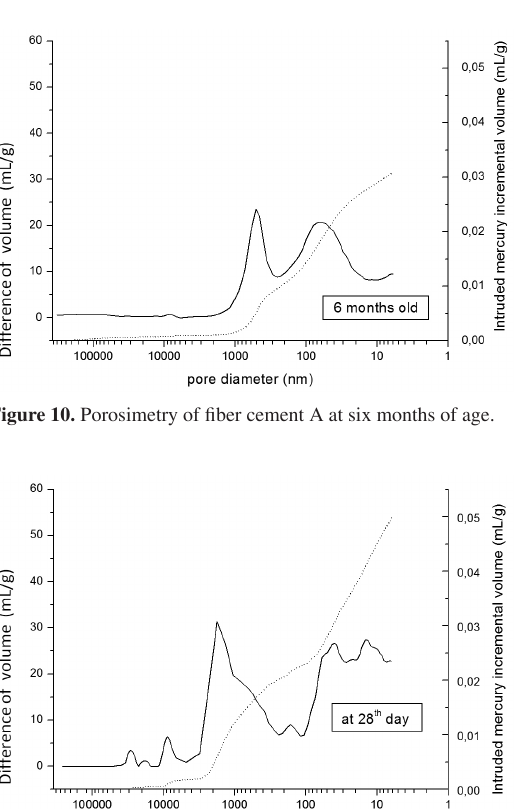
Figure 9. Porosimetry of fiber cement A at 28 days.